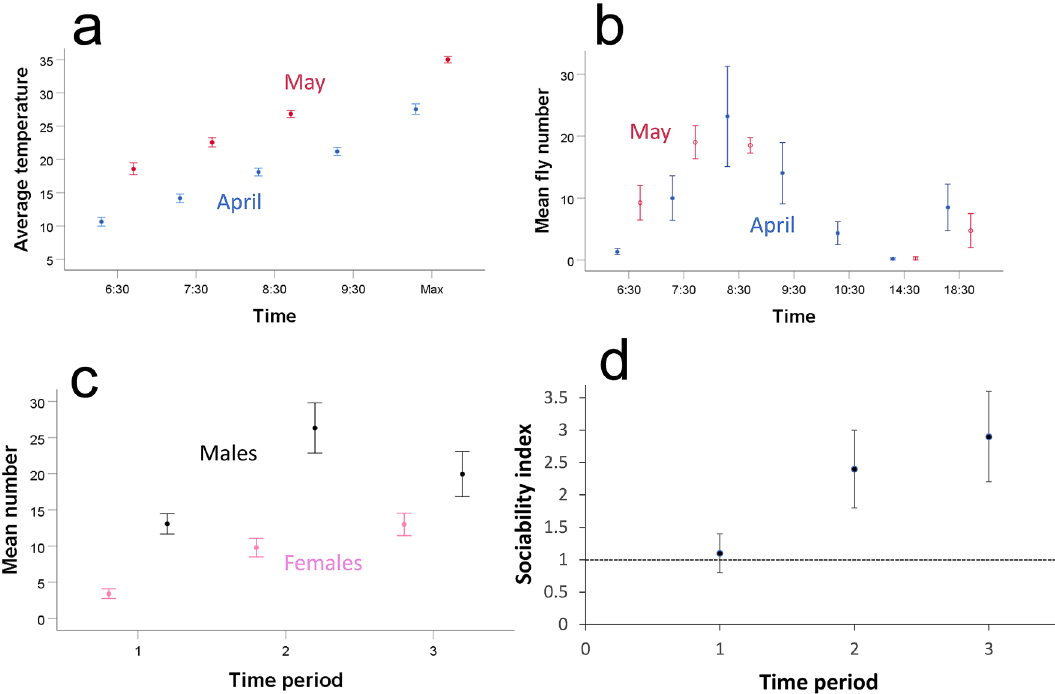
Figure 2. ( a ) The average (± SE) temperature during the mornings of observations and the average (± SE) maximum temperature (marked as “Max” on the X legend) for the same days (n = 6 days in April and 9 days in May; note that I did not record the 9:30 AM temperature in May). ( b ) The average (± SE) number of flies at the fruits during the whole-day scans (n = 5 days; note that I did not record fly numbers at 9:30 AM and 10:30 AM in May). ( c ) The average (± SE) number of flies at the fruits during the 3 morning periods (n = 15 days). These morning periods were at 7:30, 8:30 and 9:30 in the two April replicates and at 6:30, 7:30 and 8:30 in the three estimated marginal means from the GLMM (n = 15